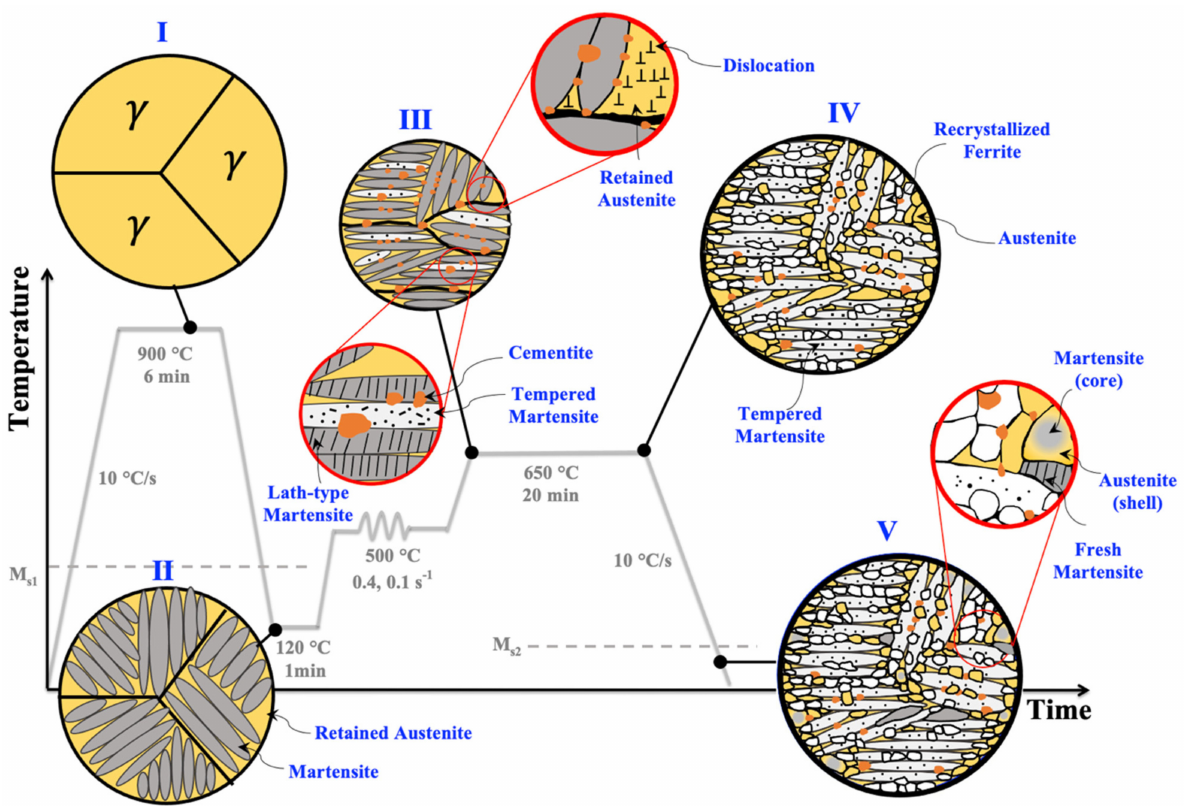
Figure 10. Schematic illustration of the microstructure evolution during the annealing (I), quenching to 120 ◦ C (II), warm deformation at 500 ◦ C (III), and IAT at 650 ◦ C (IV) resulting in a heterogeneous multiphase microstructure